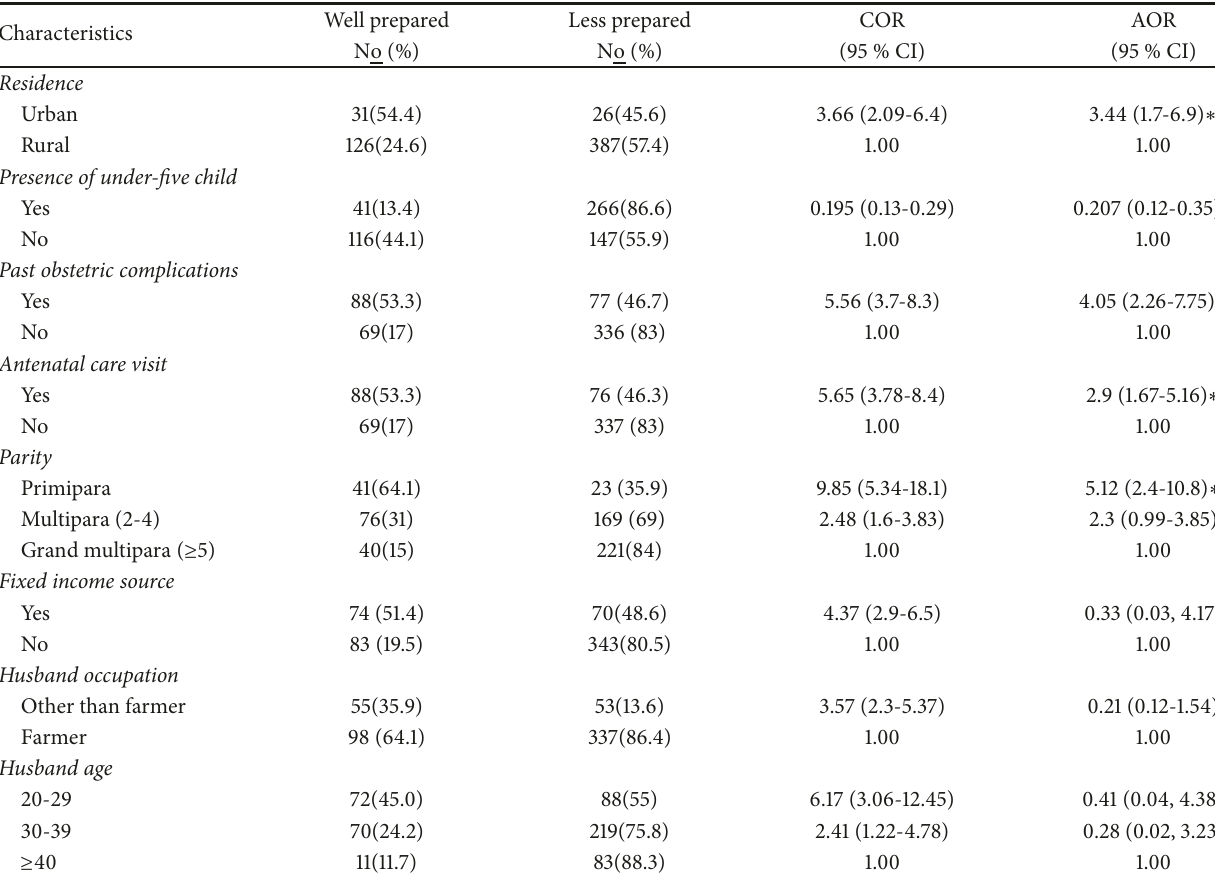
Table5:PredictorvariablesofbirthpreparednessinmultivariableanalysesamongstudyparticipantsinJardegaJarteDistrict,OromiaRegion, western Ethiopia, from January 1 to February 2,